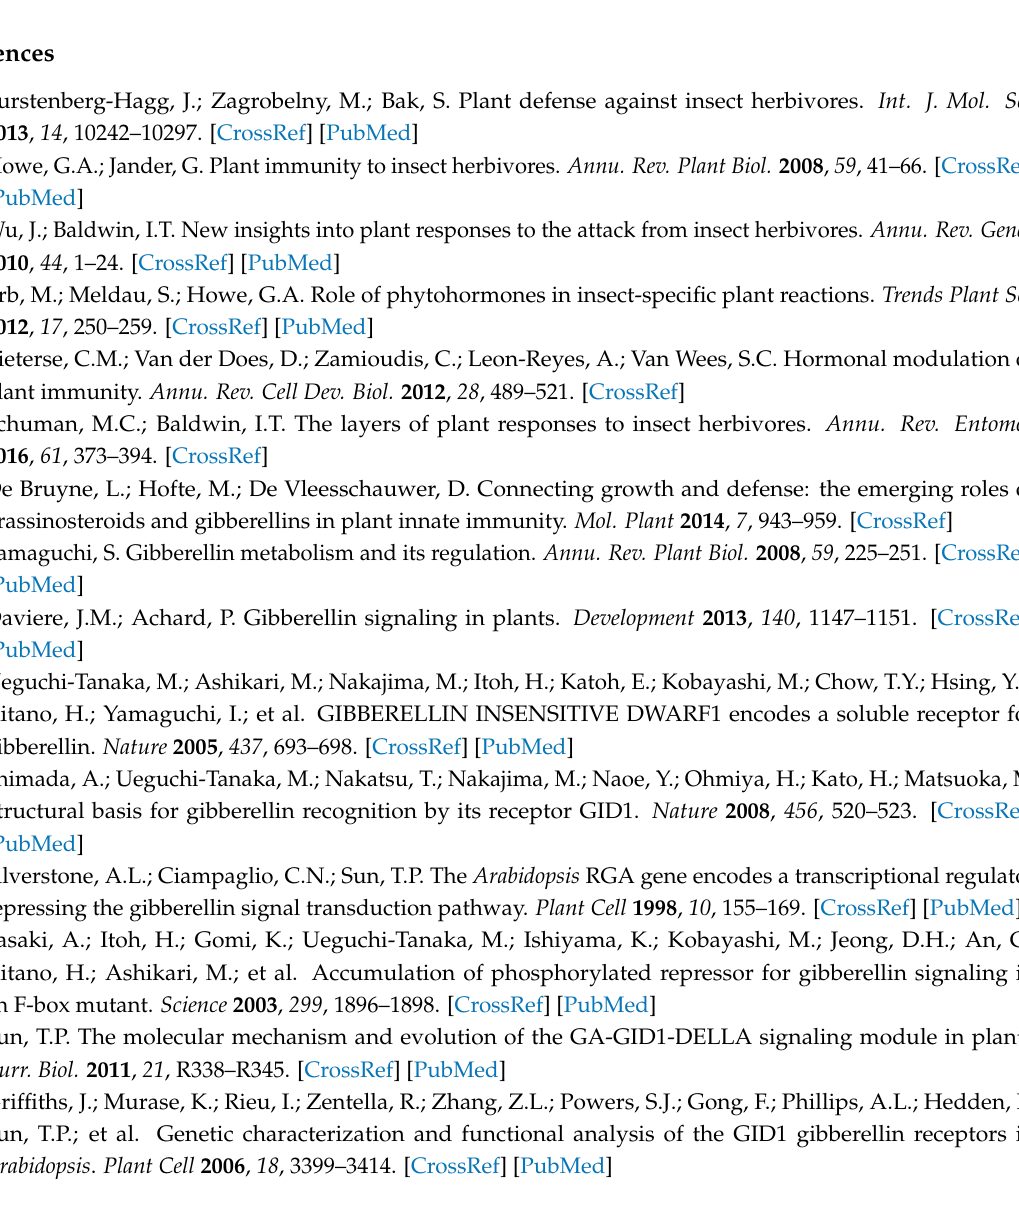
Supplemental Figure S3: DNA gel-blot analysis of oe-GID1 lines and WT plants; Supplemental Figure S4: Mean mass (+SE, n = 20) of the above-ground part of 38-day-old plants of oe-GID1 and WT lines; Supplemental Figure S5: Mean number (+SE, n = 5) of eggs laid by 15 gravid BPH females on oe-GID1 and WT plants for 12 h. Supplemental Figure S6: Constitutive levels of Lignin in WT and oe-GID1 plants; Table S1: Primers and probes used for qRT-PCR of target